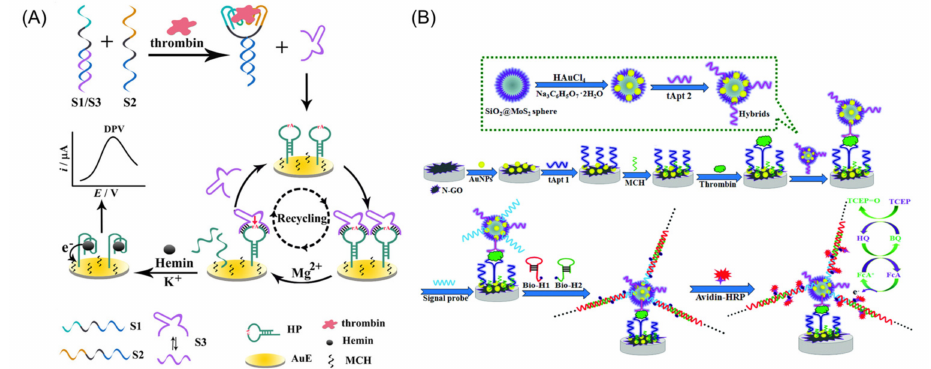
Figure 8. Schematic illustration of electrochemical sensors for thrombin detection. ( A ) The strand displacement and DNAzyme signal amplification cascaded thrombin detection strategy. Adapted with permission from Ref. [92]. Copyright (2016), American Chemical Society. ( B ) Preparation of the sandwich-type sensor. Adapted with permission from Ref. [93]. Copyright (2017), Royal Society of